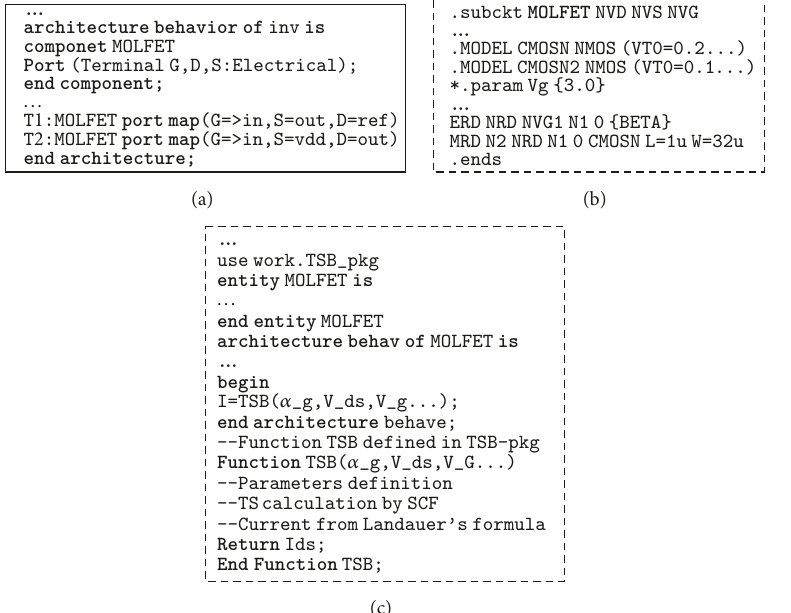
Figure 3: A short description of VHDL code of the framework, (a) inverter circuit implemented using the MOLFET device, (b) FBE model, and (c) TSB model description. After defining the device in models we can use it as VHDL component in any circuit ranging from inverter to P4